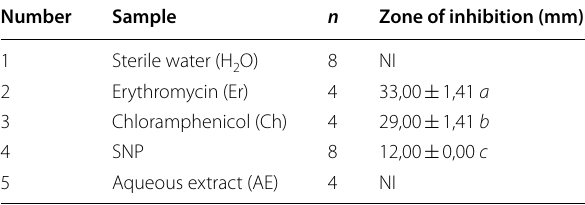
Table 2 Antibacterial activity of SNP synthesized from aqueous leaf extract of L.